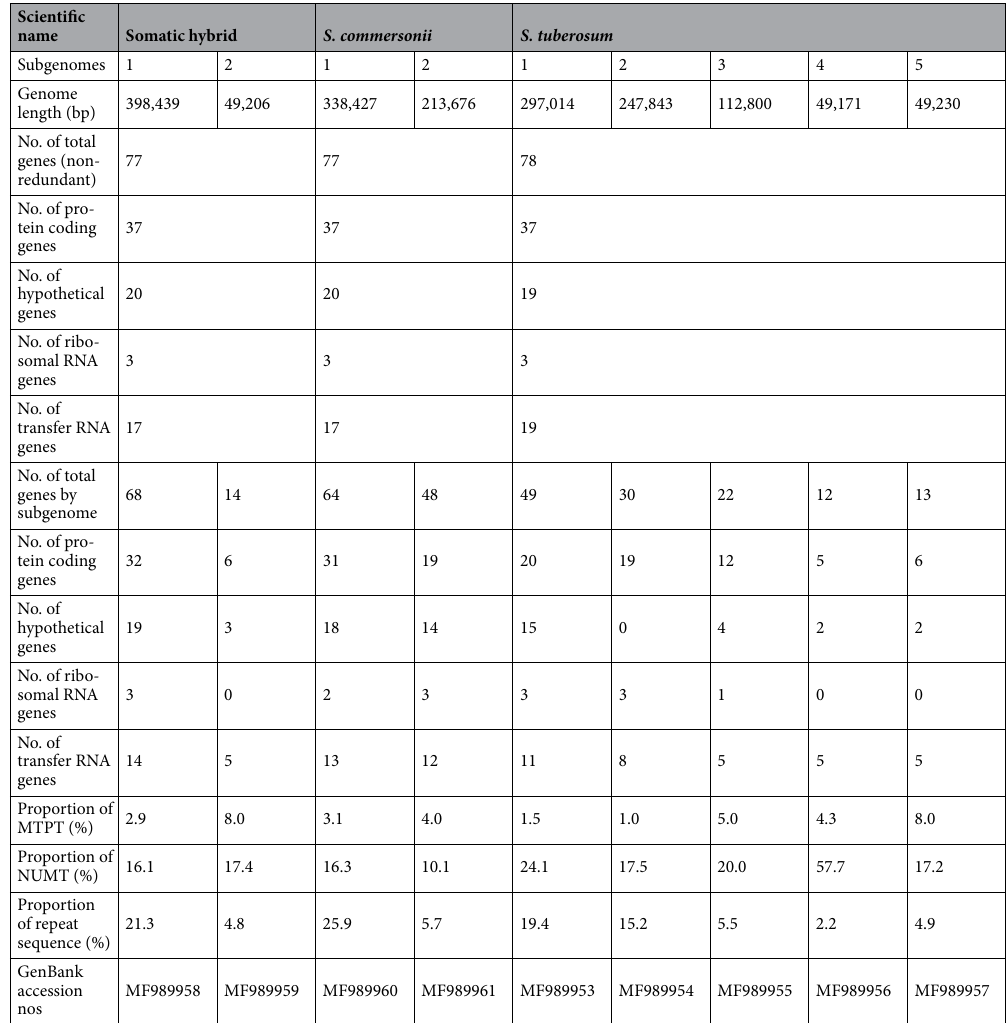
Figs. 1 and S2). The StSc mitogenomes contain four large repeats (more than 1 kb) (R1, 11,916 bp; R2, 11,846 bp; R3, 1643 bp; and R4, 1024 bp) that might contribute to subgenome reshuffling (Table S5, Figs. 1 and S2). Confirmation of the somatic hybrid in mitochondria and nuclear genomes. We compared plastomes, mitogenomes, and nrDNAs among St, Sc, and StSc genomes. The StSc plastome was identical to Sc plastome 37 . Meanwhile, the StSc mitogenome shows a complicated structure with unique genes derived from both species (Table S3, Fig. 2). Among 71 common genes, 21 PCGs ( nad3, nad4, nad4L, nad5, nad6, sdh3, cox2, cox3, atp1, atp4, atp8, atp9, ccmB, rps3, rps4, rps12, rps13, rpl5, rpl10, rpl16, and mttB ) were found identical across the three mitogenomes (denoted as green boxes on Fig. 2) and their origin in the StSc genome could not be determined; 12 PCGs ( nad1, nad2, nad7, nad9, sdh4, cob, cox1, ccmC, ccmFc, rps10, rpl2, and matR ) were found identical with Sc (represented as sky-blue boxes in Fig. 2) and 2 PCGs ( atp6 and ccmFN ) were identical with St (pink boxes in Fig. 2). Therefore, it is likely that the majority of the somatic hybrid mitogenomes origi- nated from Sc (Fig. 2). GISH data using Sc genome probes revealed strong signals in 24 chromosomes but weak signals in the other 24 chromosomes in the StSc somatic hybrid (Fig. 3A). We also assembled and compared 45S nrDNA cistron sequence of three species. For example, multiple aligned position at 191 bp represents ‘T’ genotype in St and ‘C’ genotype in Sc. However, in StSc, it was identified that 75.6% of ‘T’ and 24.4% of ‘C’ were present. In conclusion, the overall 45S nrDNA sequences of StSc revealed both genotypes with average about 70 and 30 ratio for Sc and St, respectively (Fig. 3B).